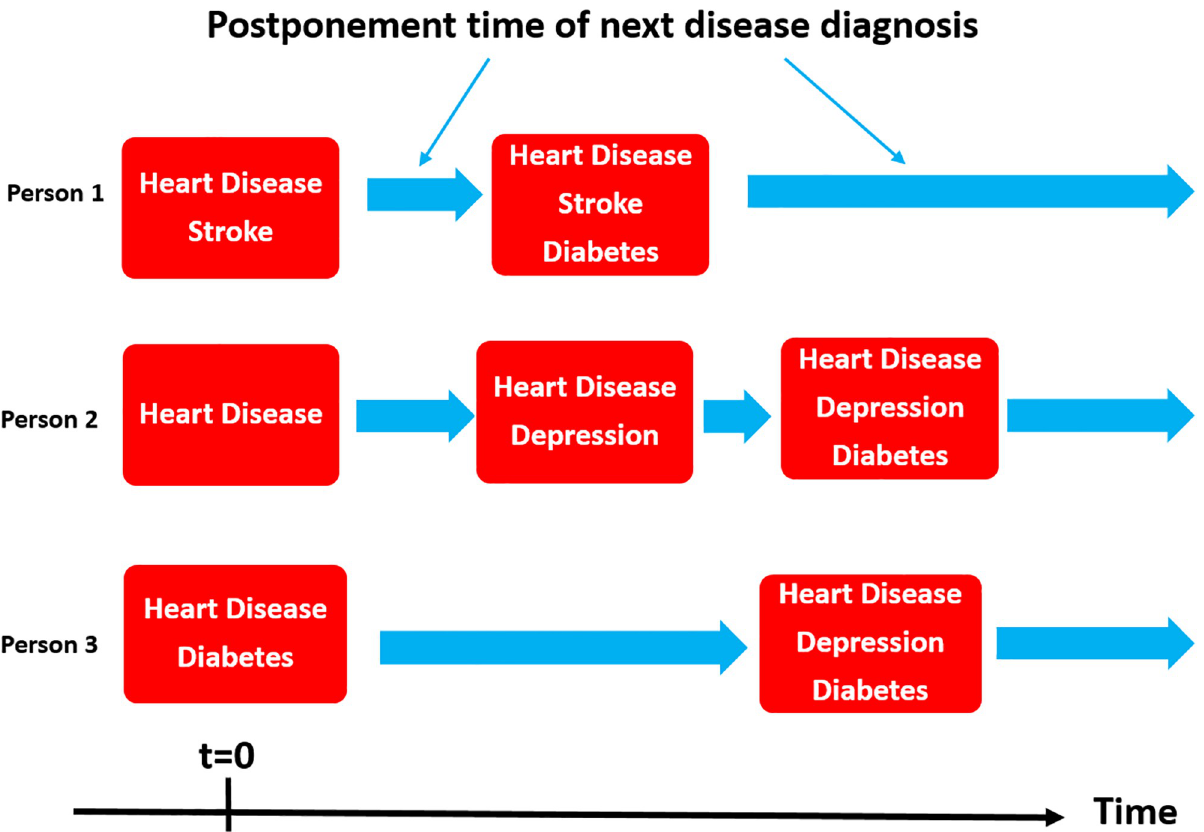
Fig 1. Disease portfolio development. Illustration of disease portfolio trajectories following heart disease diagnosis for three individuals.